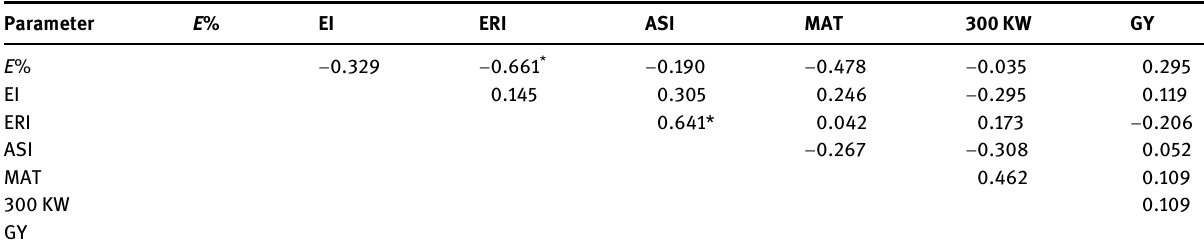
Signi fi cantly di ff erent at 0.05 level of probability; E %, emergence percentage; EI, emergence index; ERI; emergence rate index, ASI; anthesis - silking interval; MAT, physiological maturity time; 300 KW, 300 kernel weight; GY, grain